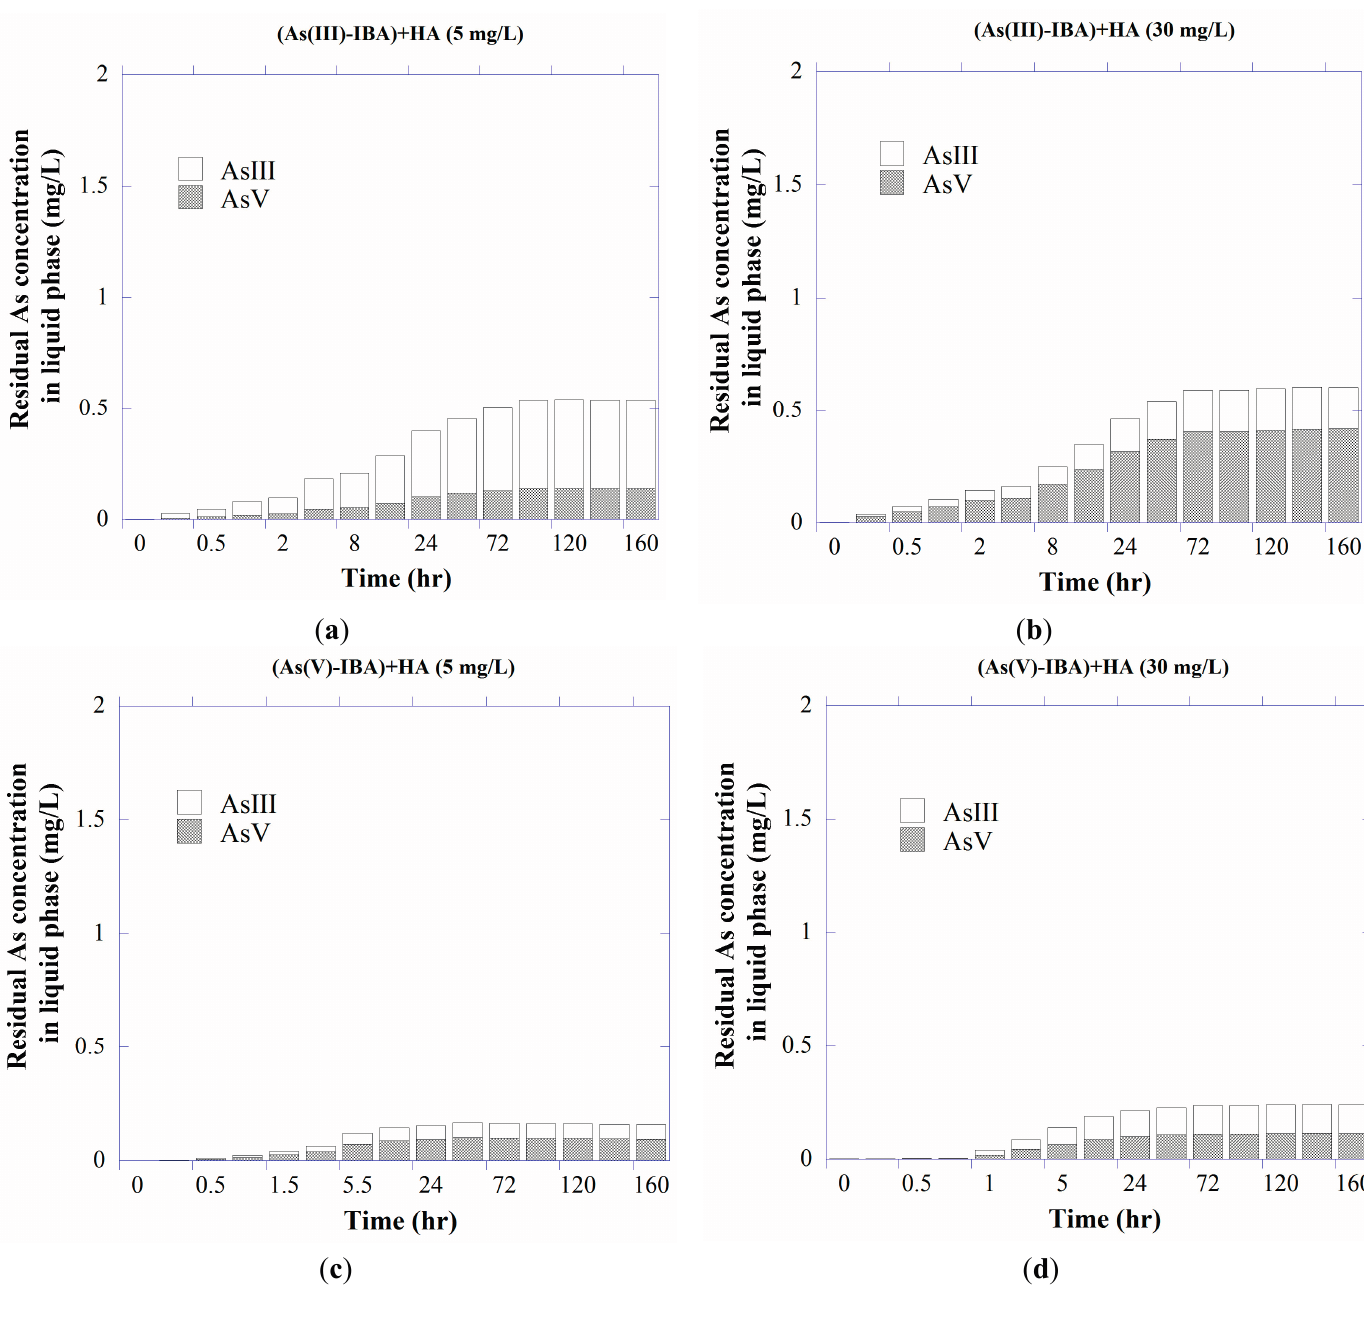
Figure 6. Desorption and redox transformation of ( a , b ) As(III) and ( c , d ) As(V) from As-presorbed IBA in the ternary (As-IBA)+HA